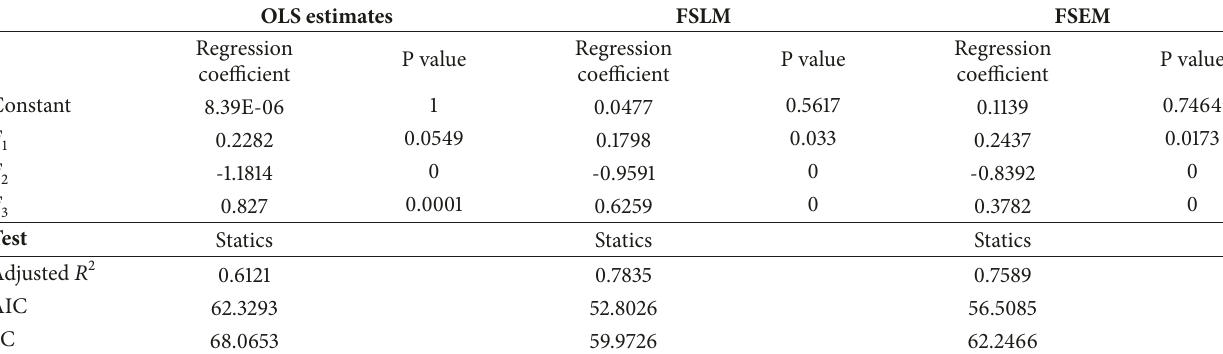
Figure 2: Residual test diagram, (a) the residual plots, and (b) the normal QQ plot of regression residuals. Table 8: The comparison between OLS regression and spatial